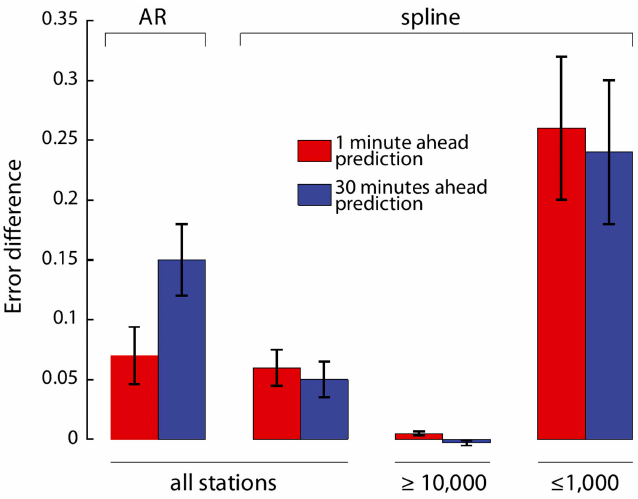
Figure 9. Fivefold cross-validation averages for 1-min-ahead (red) and 30-min-ahead (blue)